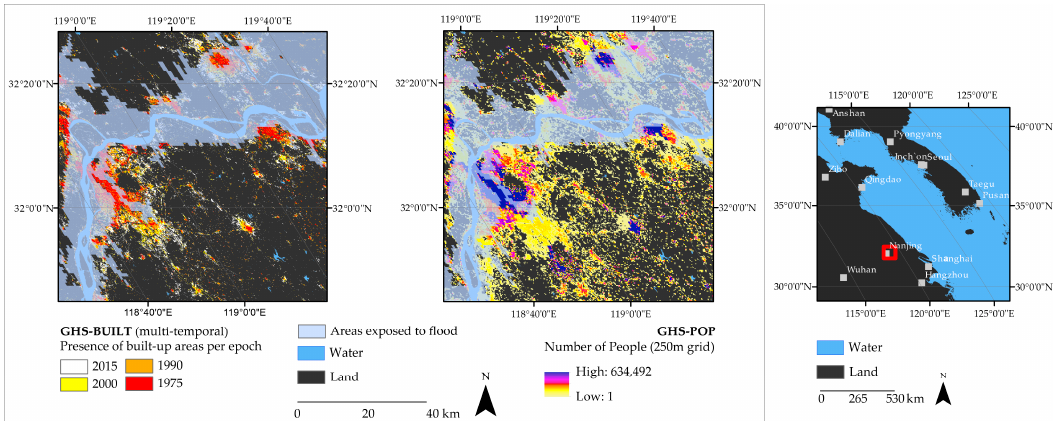
Figure 2. GHS-POP (population density), and GHS-BUILT (multi-temporal built-up density) layers overlaying with the flood hazard map over Nanjing (China). The image shows the built-up detected in recent epochs (white in 2015 to red in 1975) lay in areas exposed to